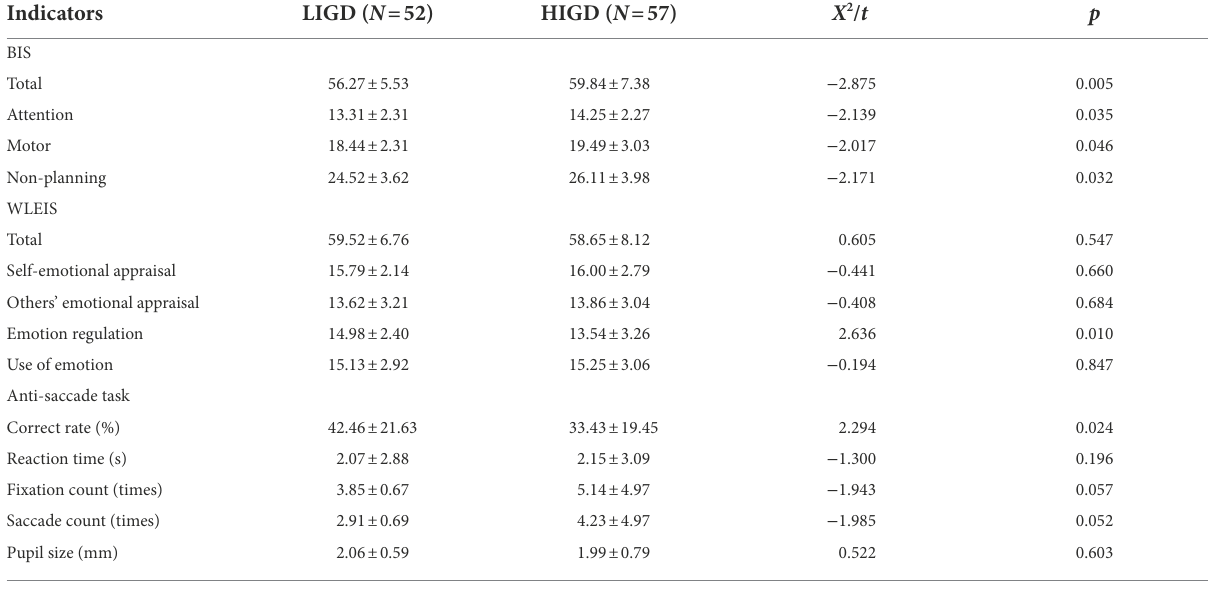
TABLE 2 Differences in clinical psychological evaluations by scales and eye tracking anti-saccade task between